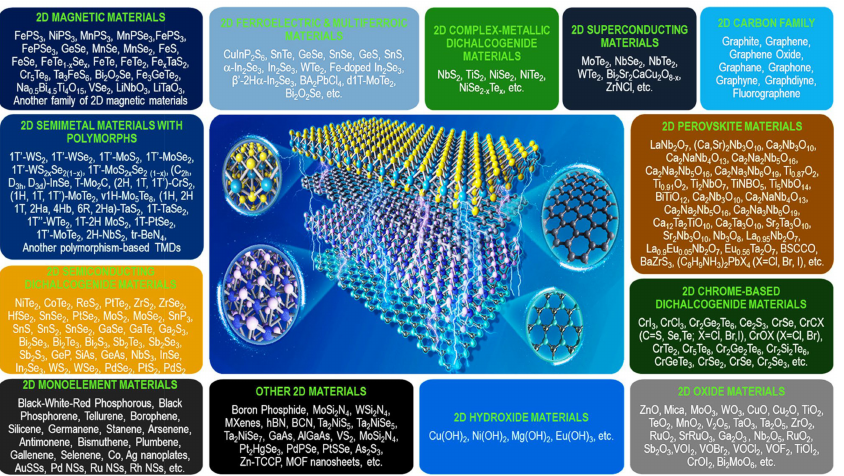
Figure 1. Summary of the current status of 2D materials presented to date. Adapted with permission from Ref. [40]. Copyright 2022, American Chemical